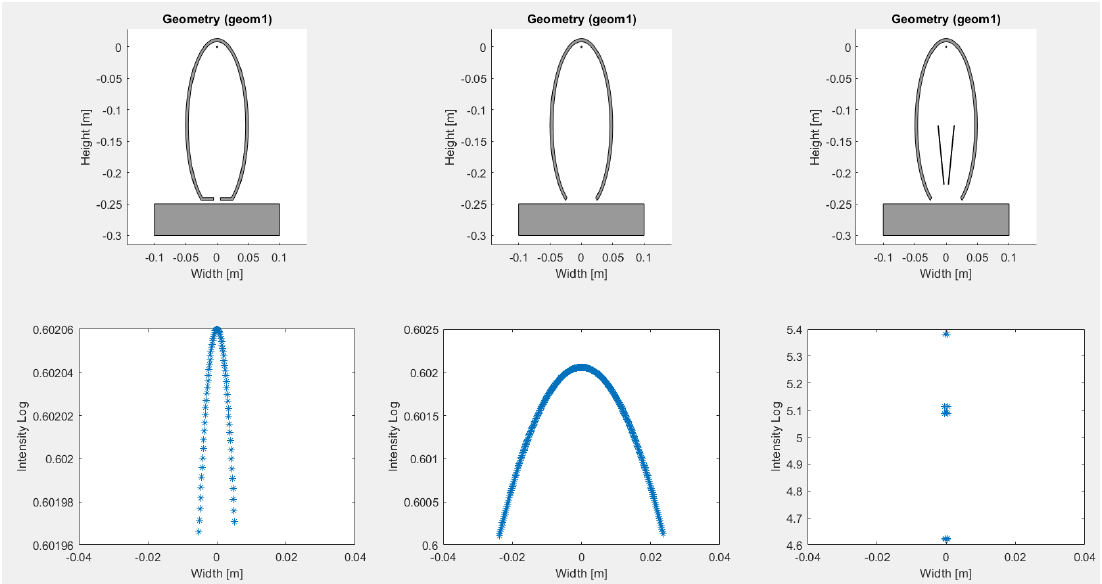
Figure 4. Multiple geometries are compared to each other. The height location of the halogen tube lamp changes to find the heating difference as result of misplacing the halogen tube lamp. Initial dimensions were different than those of the optimised